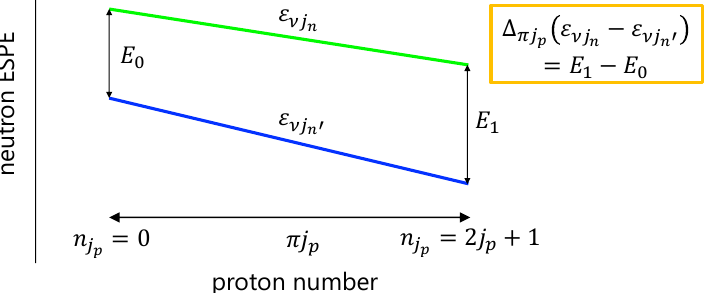
Figure 1. Schematic illustration of what is investigated in this paper. The blue and green lines are, respectively, the effective single-particle energies (ESPEs) of the neutron orbital, j n and j (cid:48) n , that change with the proton orbital, j p , filled. The evolution of the shell gap, denoted as ∆ π j main focus of this